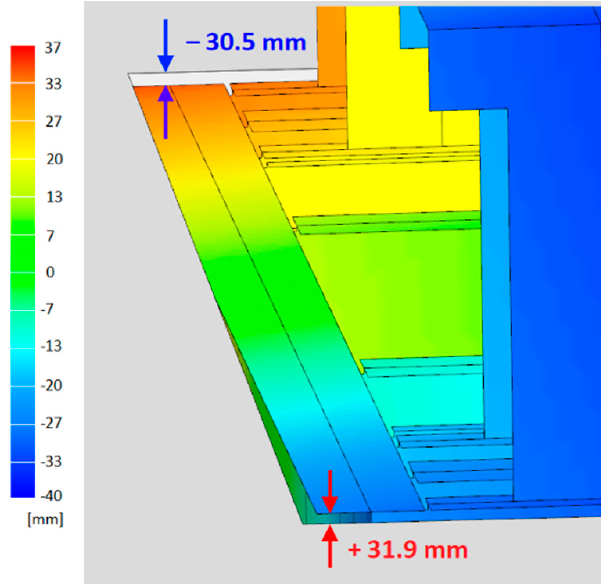
Figure 19. The structure displacements.